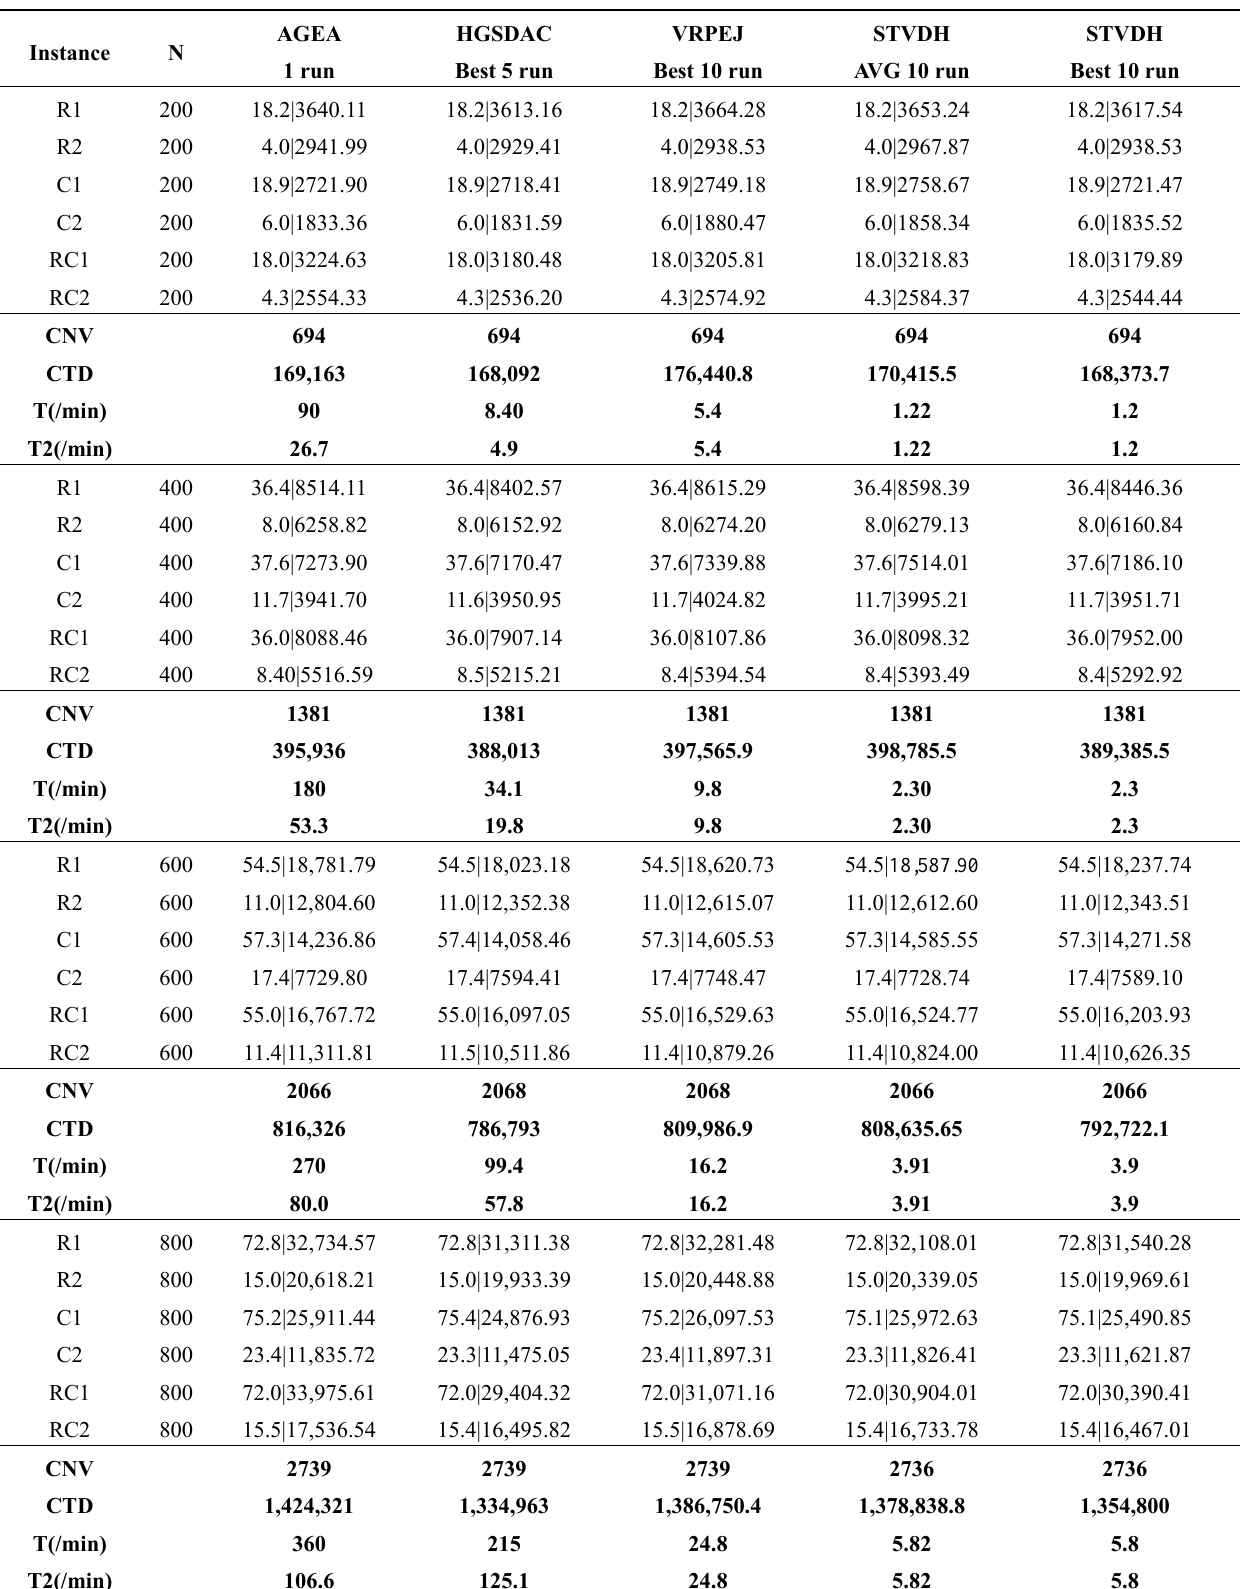
Table 3. Comparison of results on the Gehring and Homberger VRPTW benchmarks